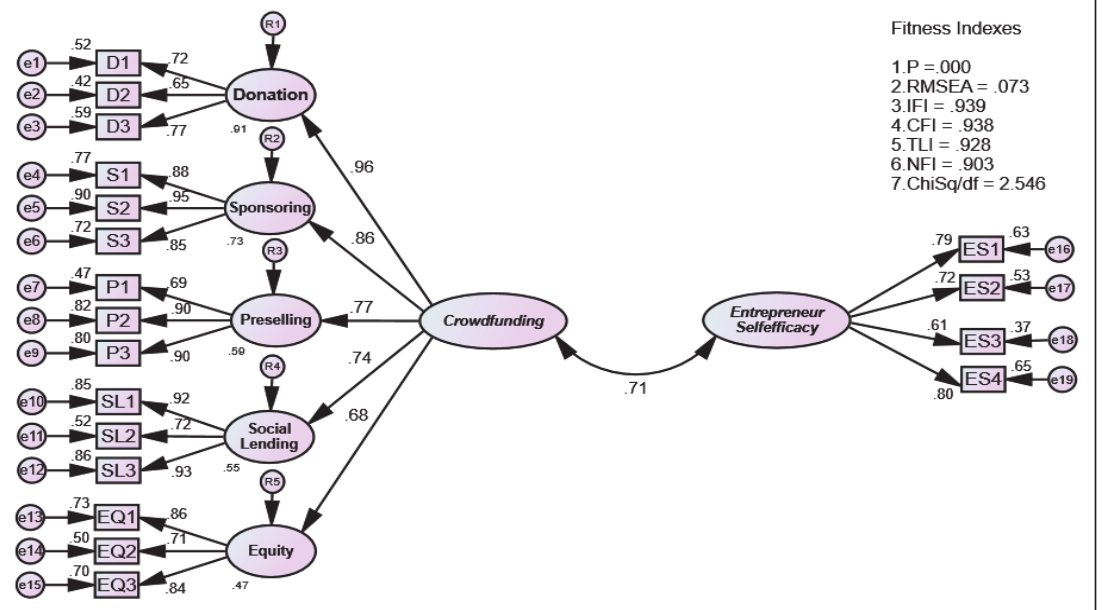
Fig. 2. The Pooled CFA Results and the Output Showed All Fitness Indexes Achieved Items Description, Internal Reliability, Composite Reliability and Convergent